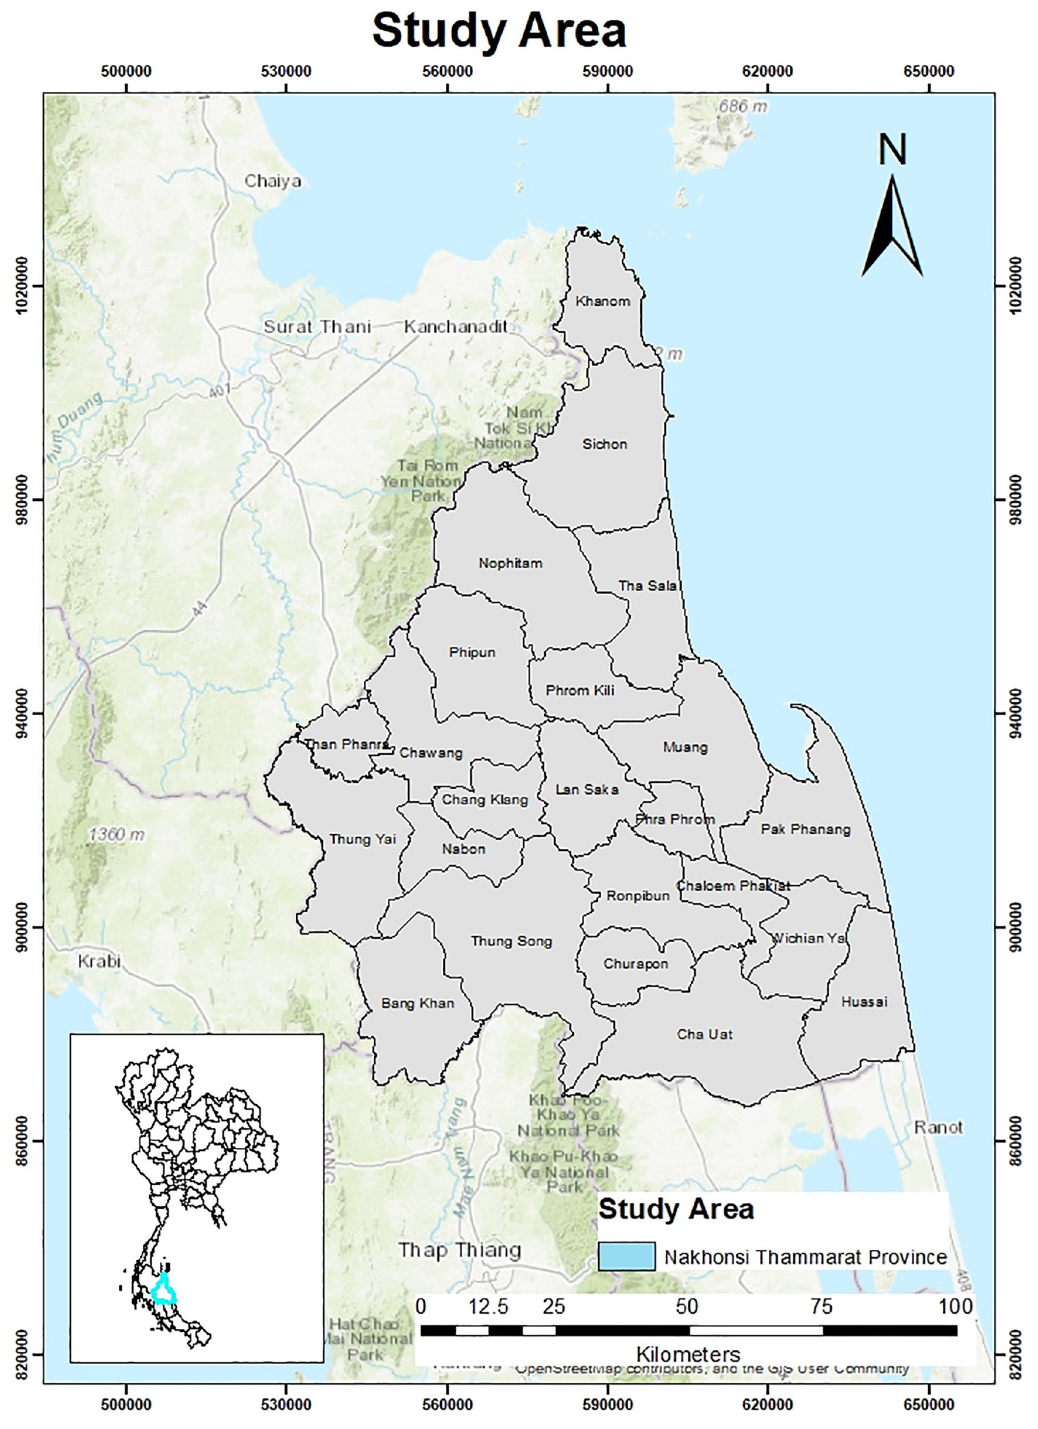
Fig 1. The study area showing Nakhon Si Thammarat Province with its 23 districts. Source: Natural Earth (http://www. naturalearthdata.com/).